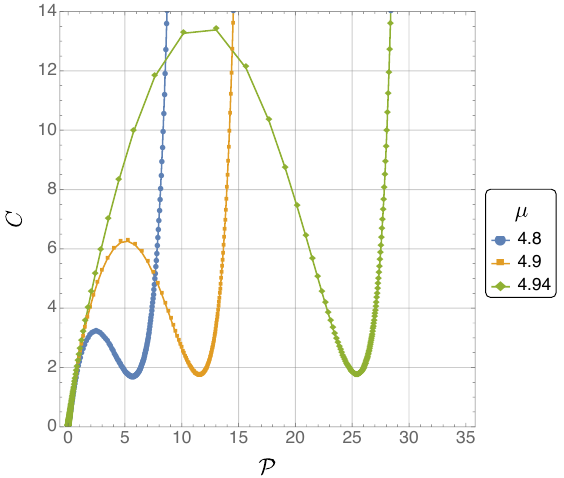
Figure 16 . Circumference of the (cid:30) circles as a function of the proper distance P for constant (cid:23) = 1 = 2, and varying (cid:22) towards the boundary with D3 ( (cid:22) (cid:25) 4 : 949). In (cid:12)gure 18 we show the induced horizon curvature measured at the axis of rotation as a function of temperature (using (cid:22) = 4 and (cid:23) = 3), where we see the horizon becoming ever more curved as the temperature decreases. We believe that the extremal solution is singular, specially in lieu of the results reviewed in [36] which rule out the existence of smooth extremal solutions other than the extremal uniform hyperbolic black holes. The horizontal purple line indicates the (cid:13)uid/gravity result, which our novel solutions seem to approach at high